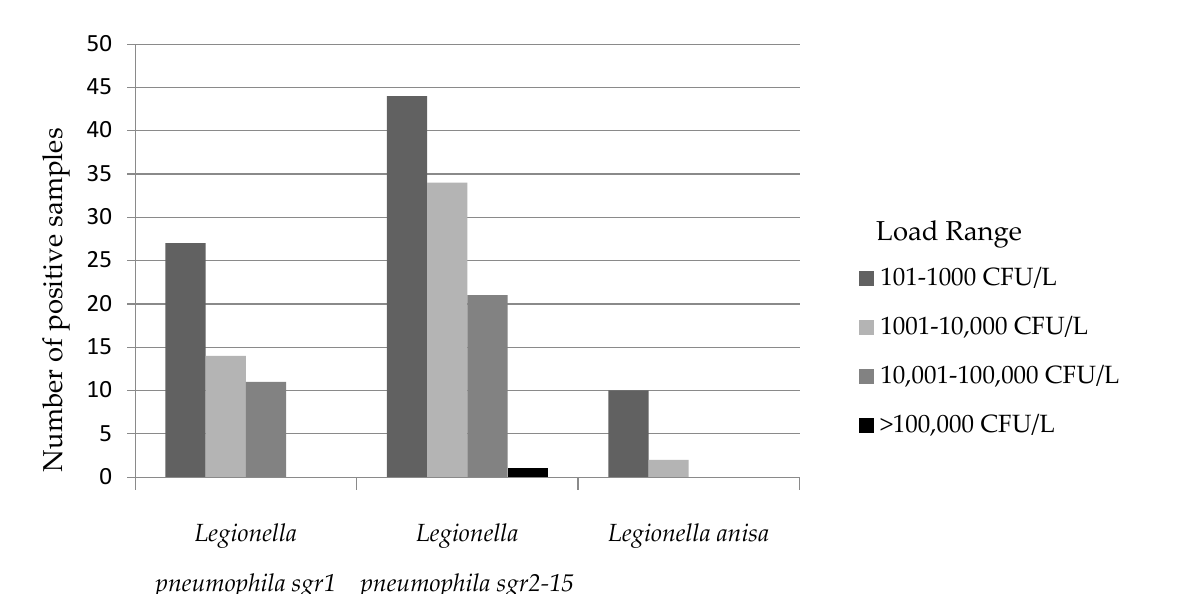
* = statistically significant test; ** = more frequent; *** = less frequent; C = multiple chi ‐ square test; them (10 samples) with a load corresponding to the lowest range of positivity. Z = post hoc Z ‐ test.